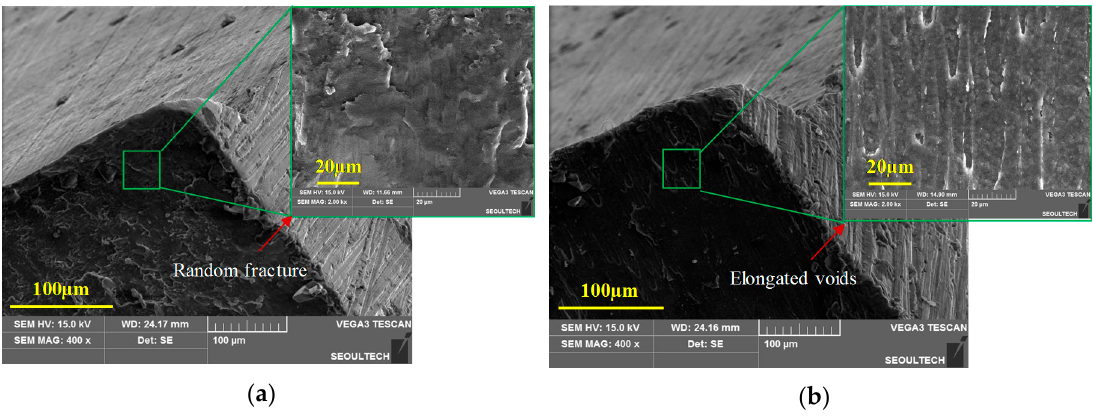
Figure 14. SEM image (2000×) of the fracture surface for 20% clearance at ( a ) 25 °C, illustrating highly random fracture surface with no visible dimples, and ( b ) 250 °C, illustrating elongated dimples in the fracture surface.